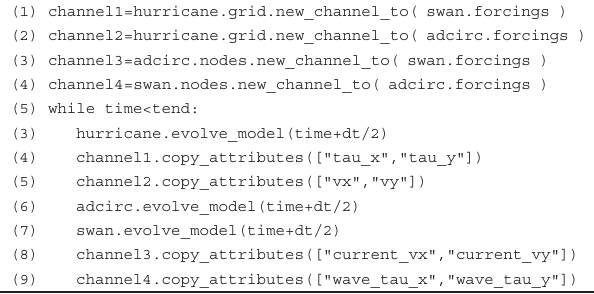
Figure 14. Definition of communication channels and evolve step corresponding to Fig.